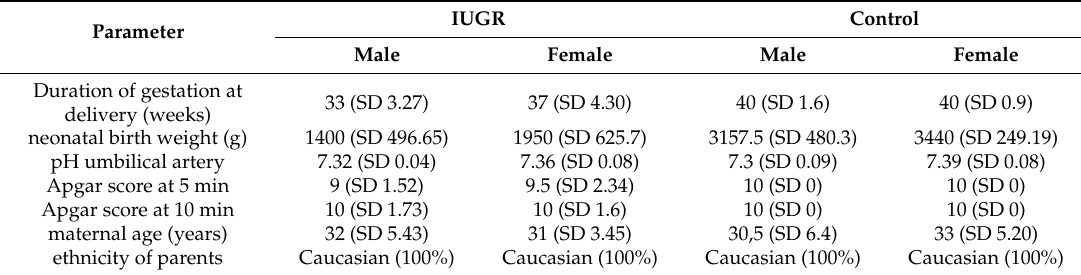
Table 1. Clinical details on the patients and newborns in the IUGR and normal control group.